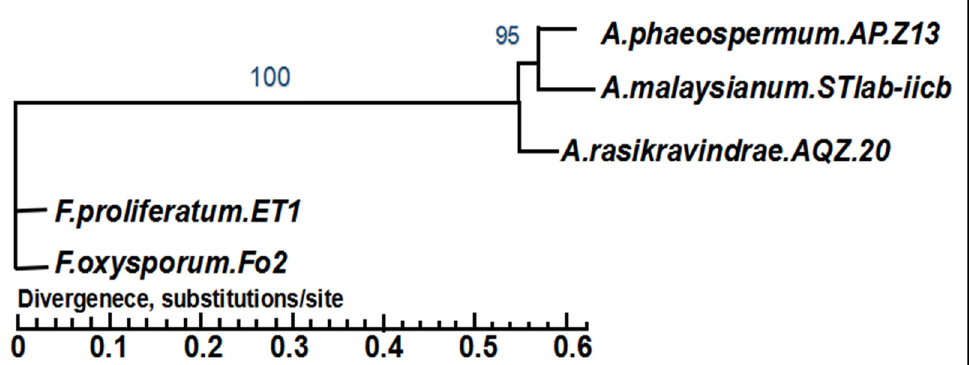
Figure 8. Inter-specific phylogenetic tree of A. rasikravindrae AQZ-20, A. phaeospermum AP.Z13, A. malaysianum STlab-iicb, F. proliferatum ET1, and F. oxysporum Fo2. As per the evaluation results of species analysis, only duplicate genes are recognized by a gene family. A. phaeospermum , A. malysi- anum, and A. rasikravindrae have shown the same evolutionary branch and have no greater evolu- tionary distance. F. oxysporum Fo2 and F. proiferatum ET1 have a different evolutionary branch from A. rasikravindrae and has greater evolutionary distance. As per the NCBI taxonomy database, A. phaeospermum , A. malaysianum STlab-iicb, A. rasikravindrae and F. proliferatum ET1, and F. oxysporum